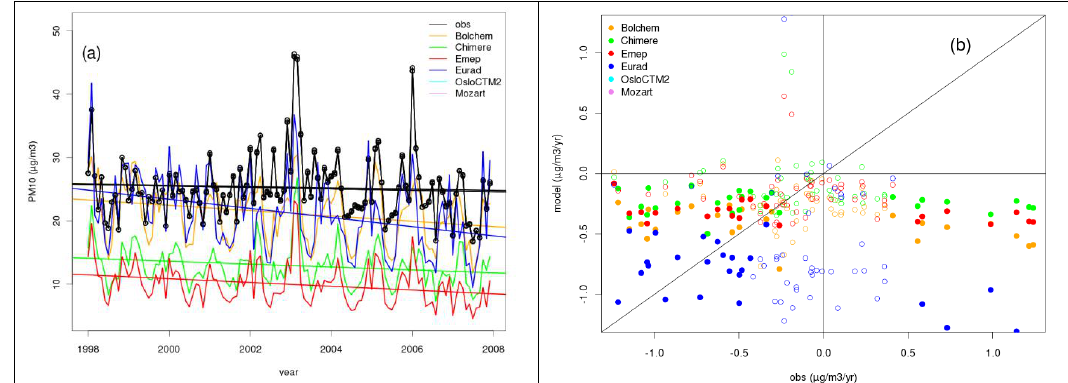
Figure 12 Same as Figure 8 for PM10. Fig. 12. Same as Fig. 8 for PM 10 .